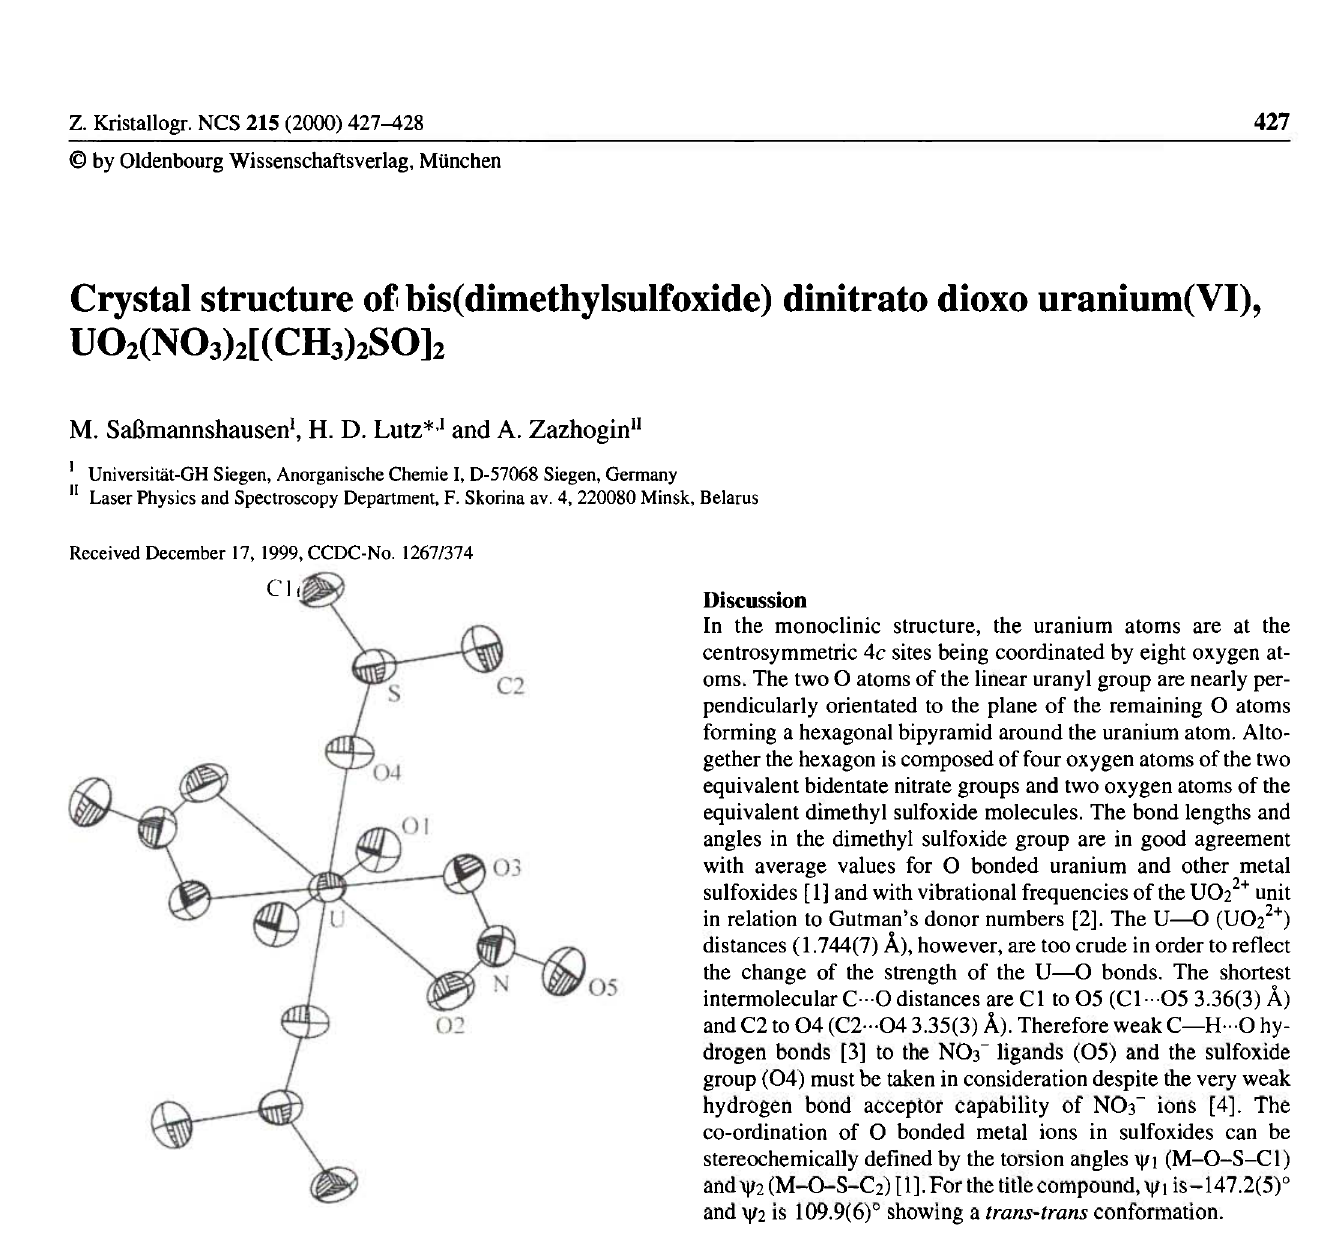
Table 1. Data collection and handling.